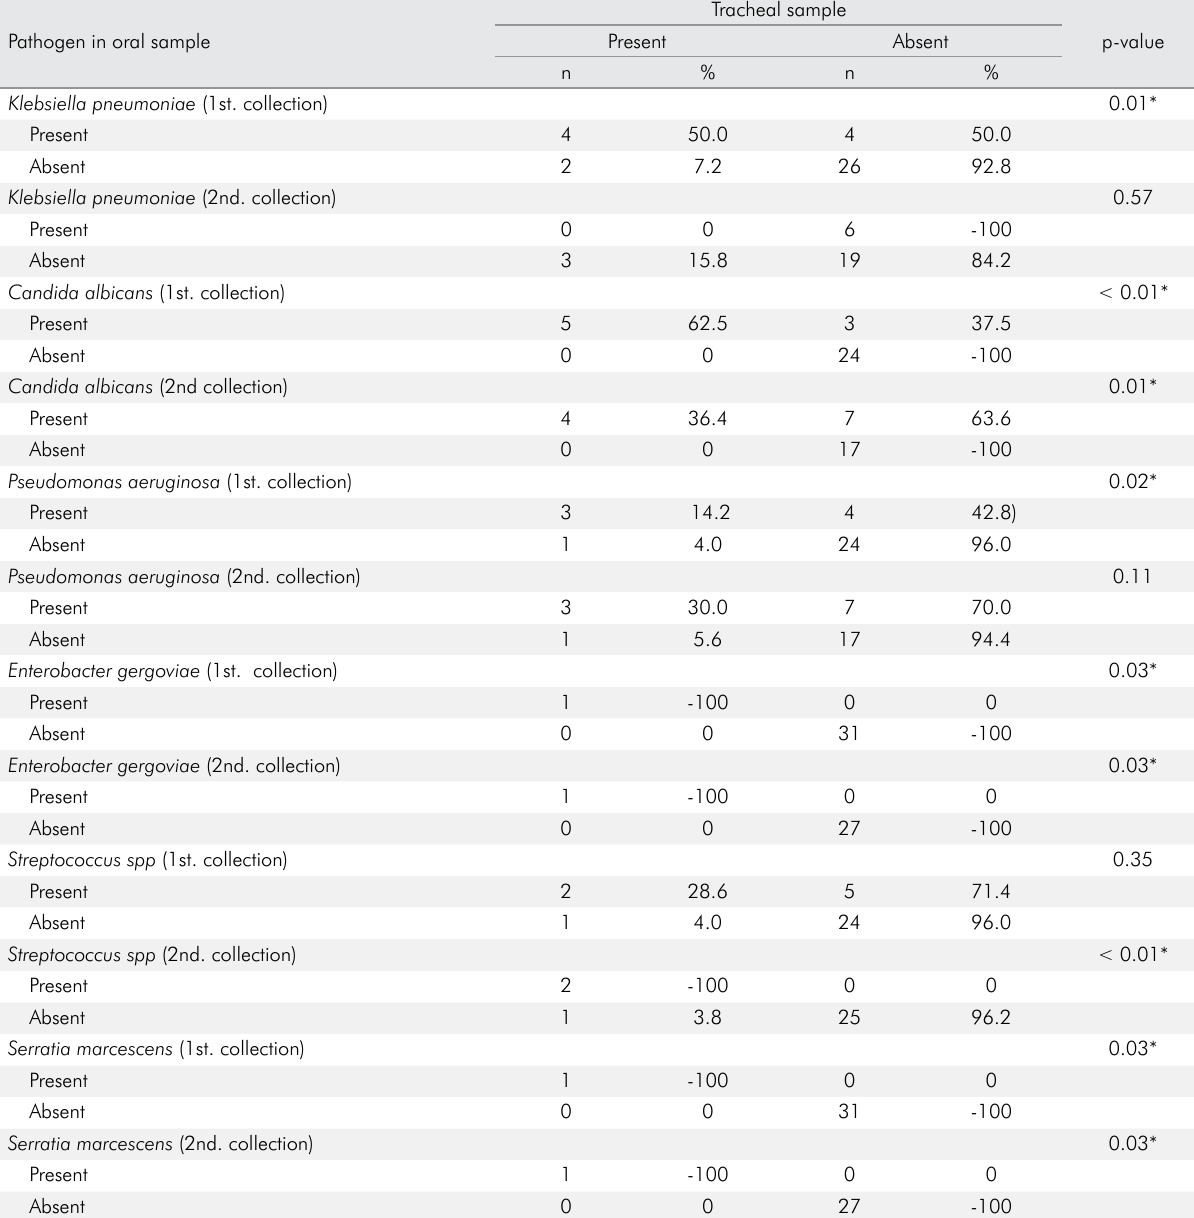
Table 4. Distribution of study participants according to the presence of the same species of microorganisms in both oral collections, as well as tracheal aspirate of mechanically ventilated patients in the adult intensive care unit. Pathogen in oral